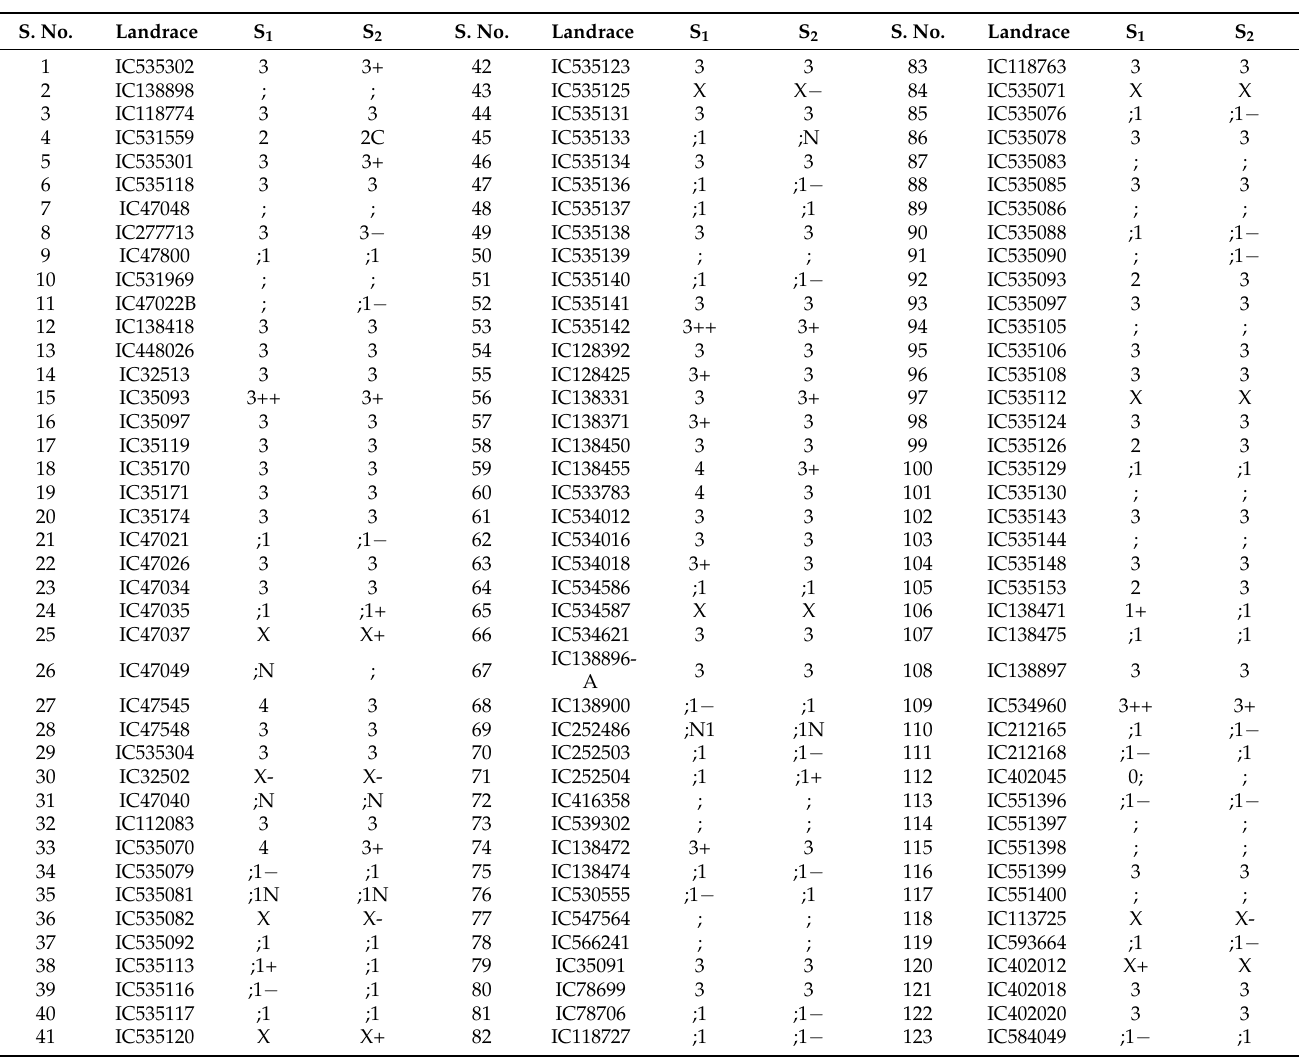
Table 1. Screening of dicoccum landraces for leaf rust at seedling stage against pathotype 77-5